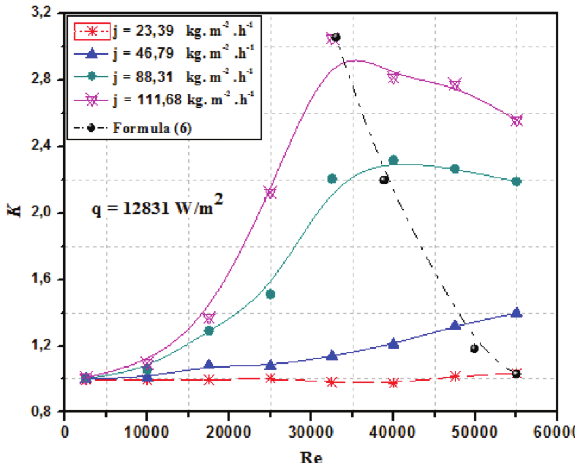
Figure 5. Variation of the heat transfer intensification factor de - pending on the Reynolds number for different water flow den - sities in the